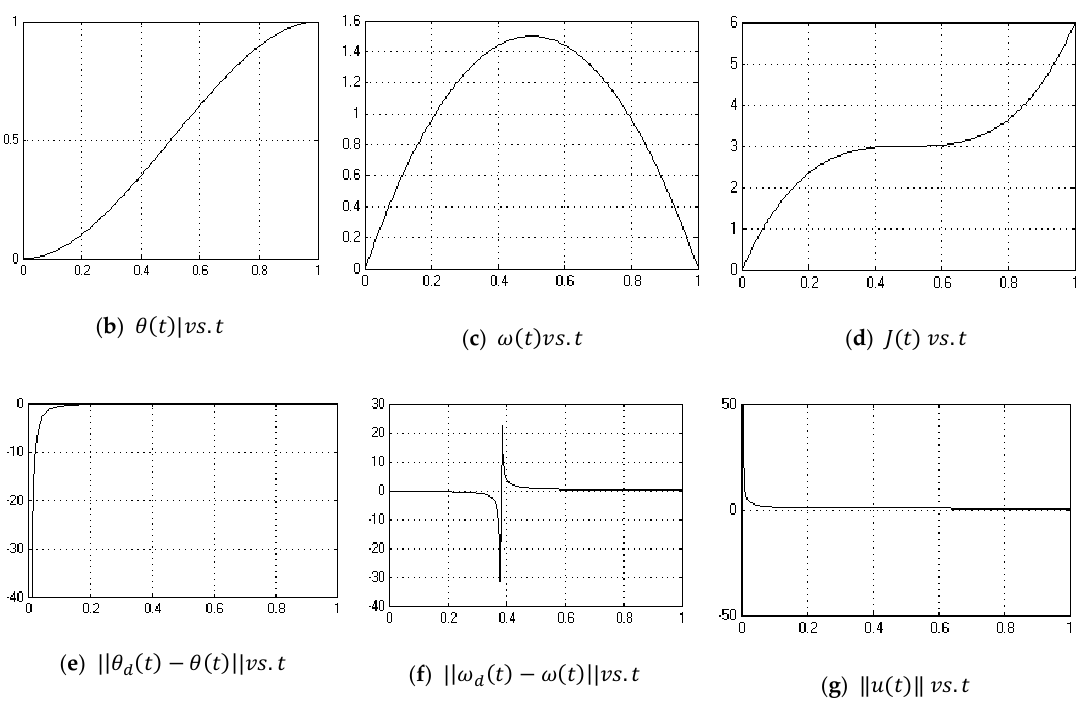
Figure A7. Feedforward/feedback PD controlled simulation.